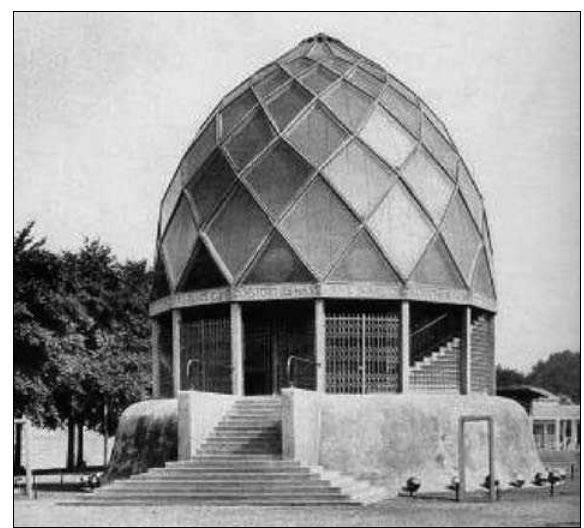
Fig. 3. Glass Pavilion (arch. bruno taut) cologne,